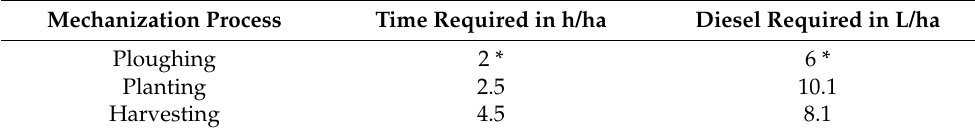
Table 9. Time and Fuel Requirements per ha for Mechanized Processes in Potato Production.